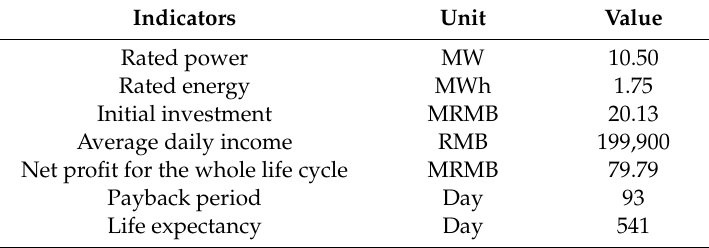
Table 2. The indicator of 10.5 MW / 1.75 MWh BESS (Battery Energy Storage